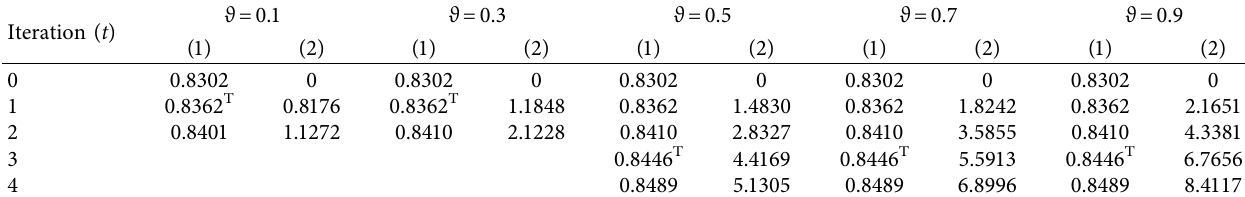
Table 21: .e group consensus levels for the different ϑ